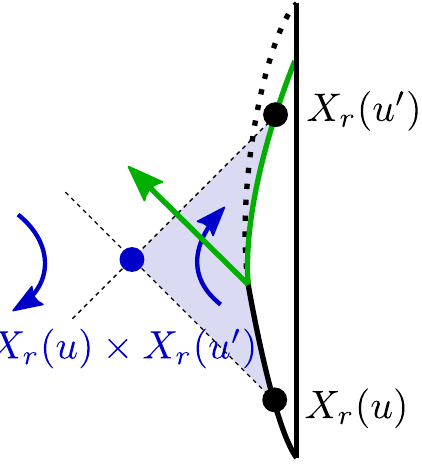
Figure 9 . The one-sided generator. An unknown amount of matter is inserted at some time between u and u (cid:31) . Our task is to detect it using right-sided observables. The blue point in the X r ( u (cid:31) ). The generator corresponding to this point fixes the causal center is proportional to X r ( u ) × wedge (shaded in light